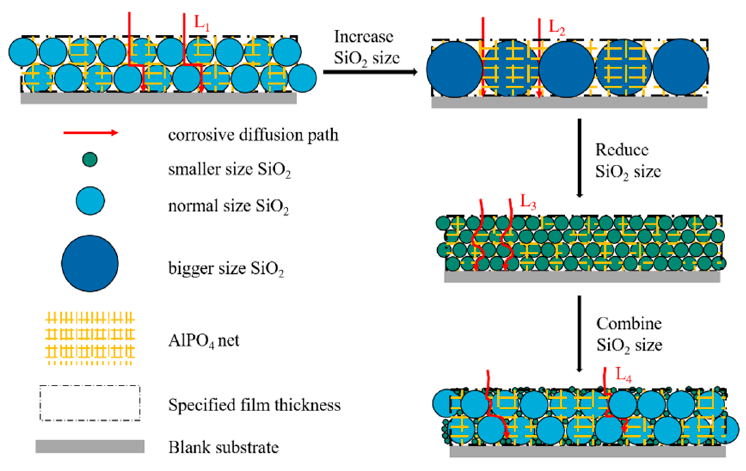
Figure 8. Scheme of the effect of silica sol particle size on the corrosion